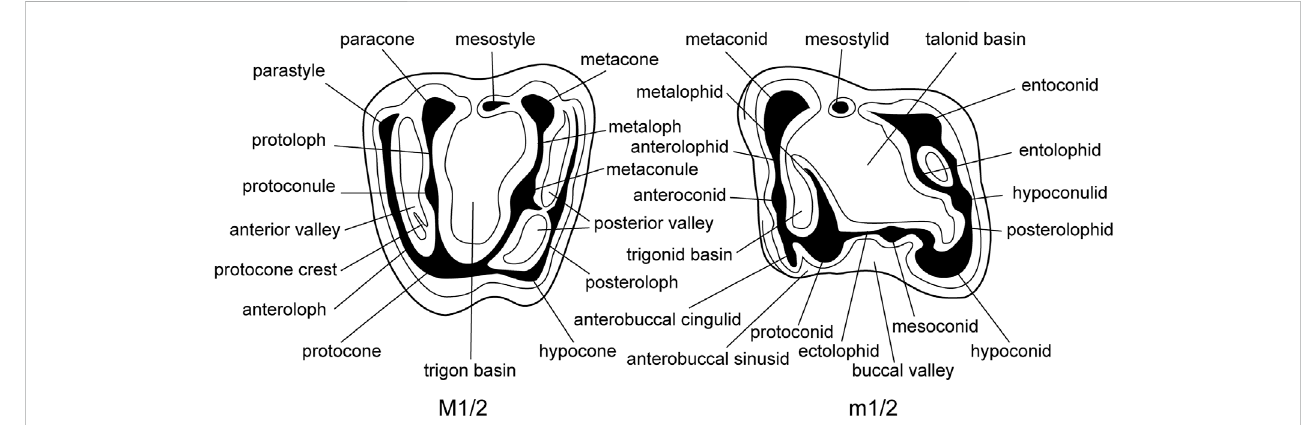
FIGURE 2 Dental nomenclature of the Sciuridae molars (cited from Qiu, 1996; Qiu, 2019).